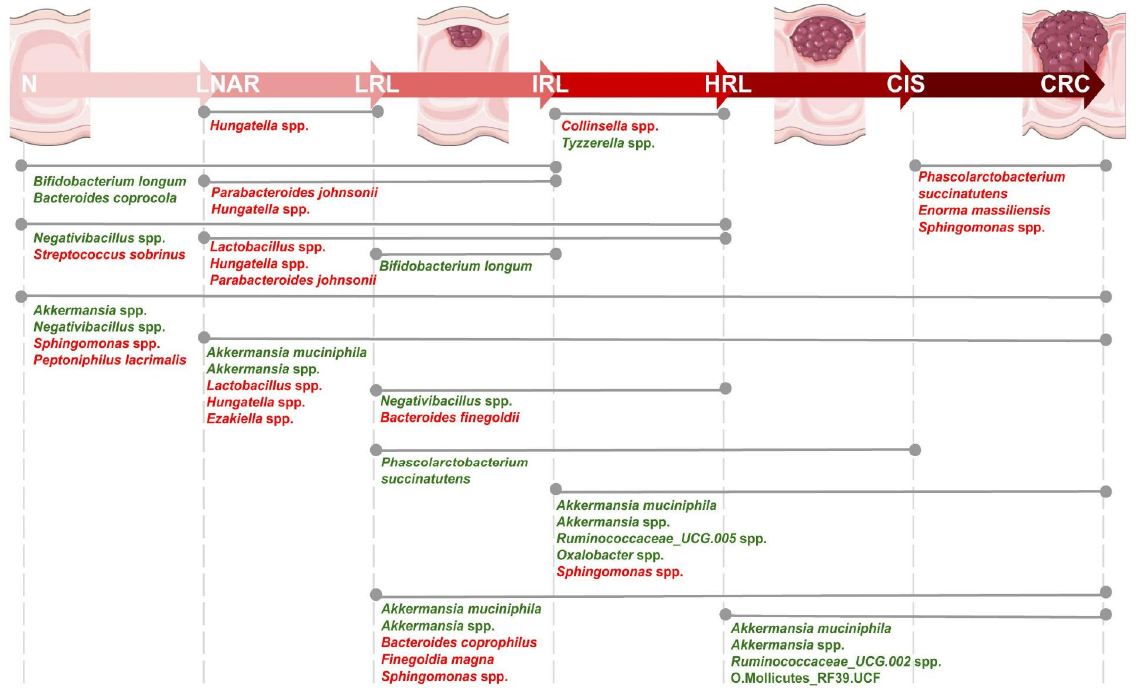
Figure 1. Representation of the 34 bacterial species found as significantly differentially abundant in pairwise comparisons of diagnoses following the path from healthy colon to colorectal cancer (Tukey test, p.adjusted < 0.05, n = 2565). Different colonoscopy diagnoses are depicted from left to right following this path, with healthier states at the left and in the following order: N, negative; LNAR, lesion not associated to risk; LRL, low risk lesion; IRL, intermediate risk lesion; HRL, high risk lesion; CIS, carcinoma in situ; CRC, colorectal cancer. Lines connecting different diagnoses indicate comparisons, with differentially abundant species names indicated. Colors in the species names indicate the direction of the change with red indicating decrease and green increased relative abundance with respect to the healthier state.